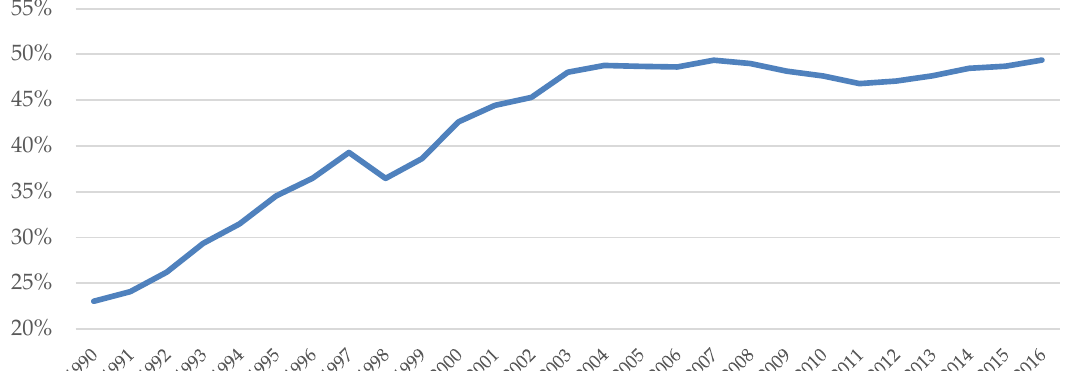
Figure 1. Food Away from Home as a share of total food expenditures. Source: Statistics Korea Household Income and Expenditure Survey.